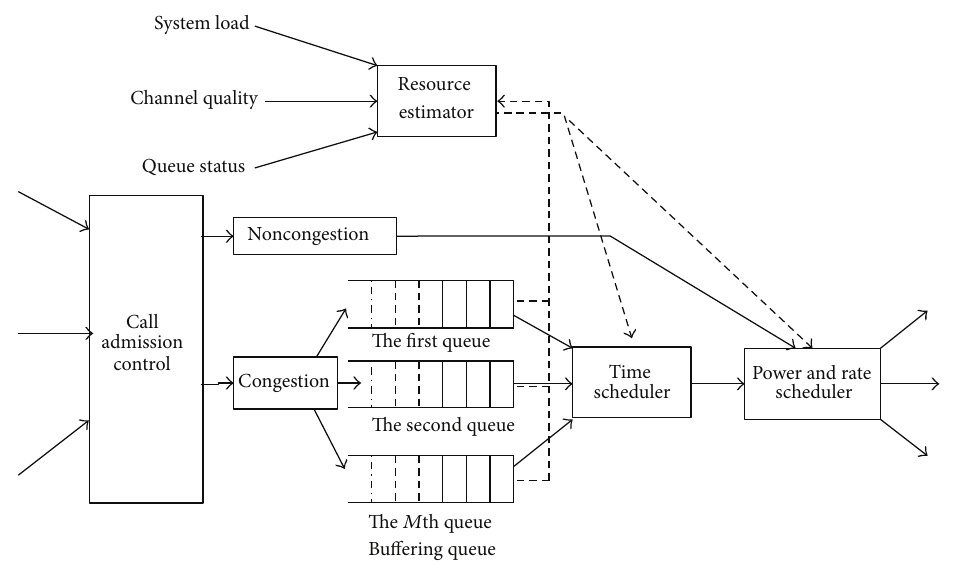
Figure 10: The IDMA MAC protocol based on channel